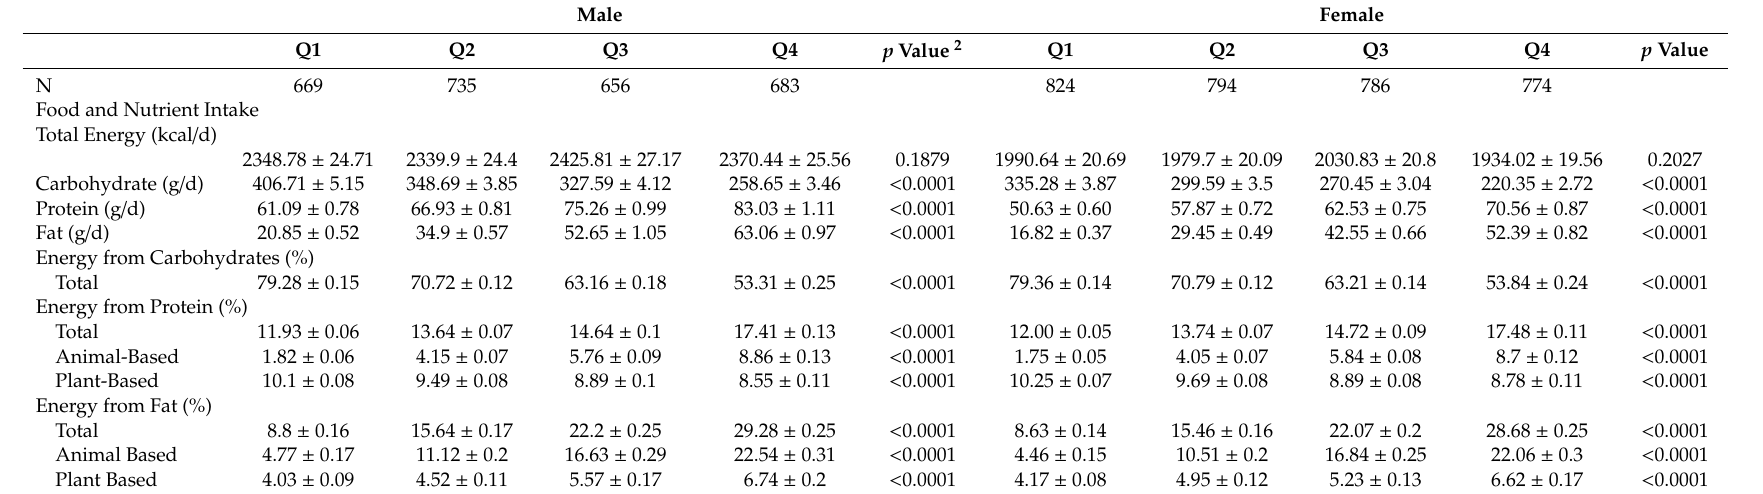
Table 3. Macronutrient intake and energy percent according to the LCD score based on gender, China Health and Nutrition Survey.